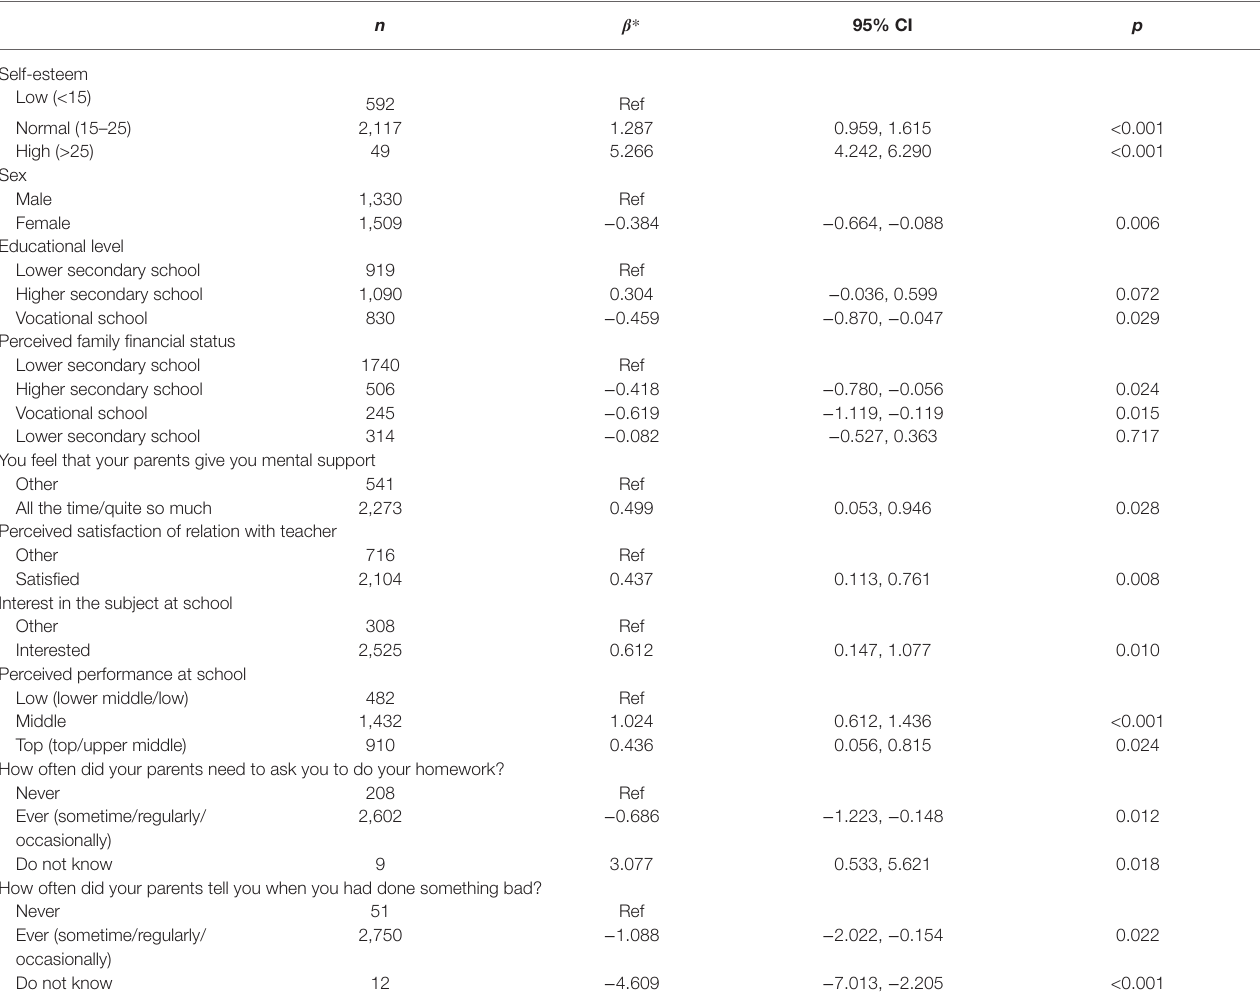
TABLE 3 | Multivariable analysis of factors associated with